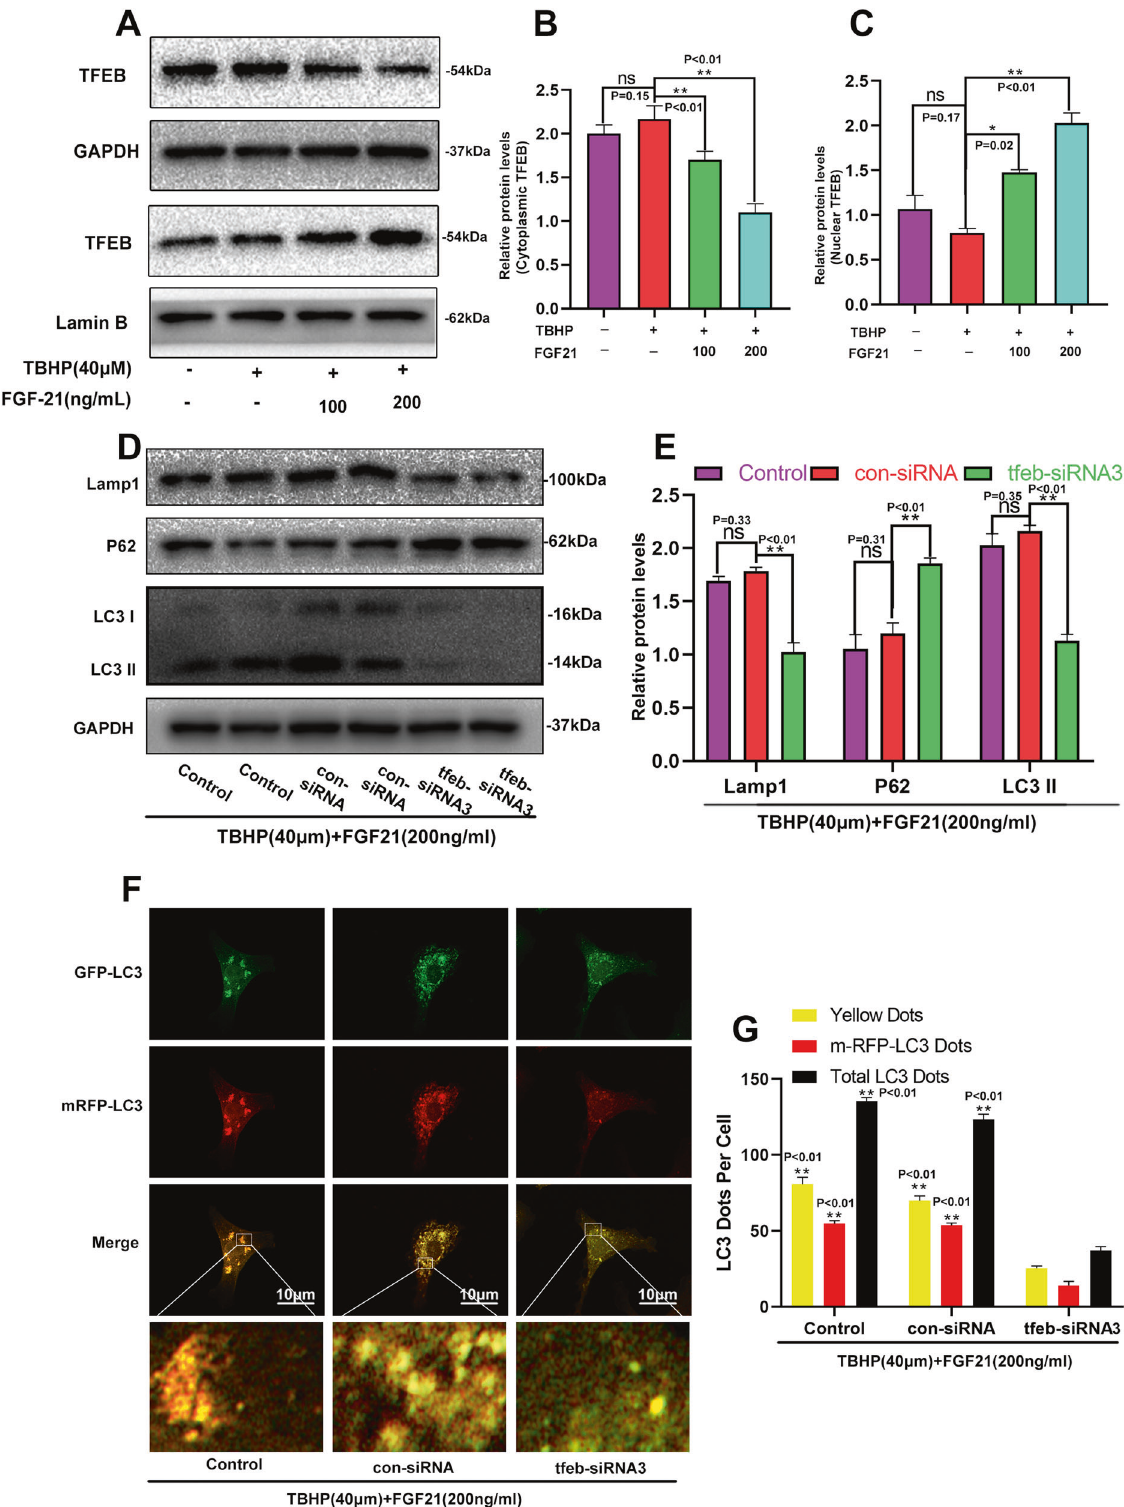
Fig. 6 FGF21 upregulated autophagy fl ux by enhancing the TFEB activity. A – C Western blotting revealed the levels of cytoplasmic TFEB and nuclear TFEB in chondrocytes as treated above. D , E Western blotting revealed the levels of the autophagic proteins (p62 and LC3II) and Lysosomal protein (Lamp1) in chondrocytes as treated above. F , G The mRFP-GFP-LC3 assay was performed to detect the number of autophagosomes in chondrocytes (yellow signal represents autophagosomes; red signal represents autophagolysosomes; scale bar: 10 μ m). The data in the fi gures are the averages ± S.D. Signi fi cant differences between the treatment and control groups are indicated as ** P < 0.01 and * P < 0.05, n =